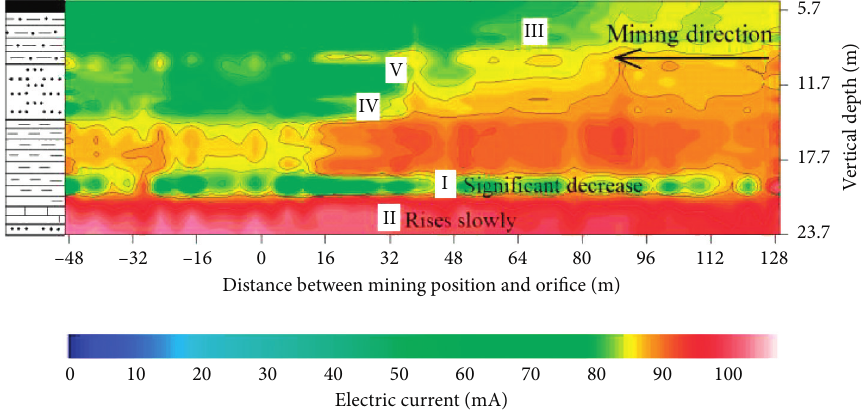
Figure 9: Nephogram of the changes in electrode current during